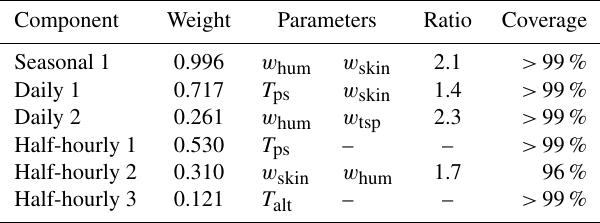
Table 3. Significant components of principal component analysis for the different tunings. The given parameters are the most domi- nant within the component and the ratio is how many times larger the factor related to the first parameter is when compared to that of the second. Coverage reveals how much of the component is ac- counted for by the given parameters (sum of the weights of given vector